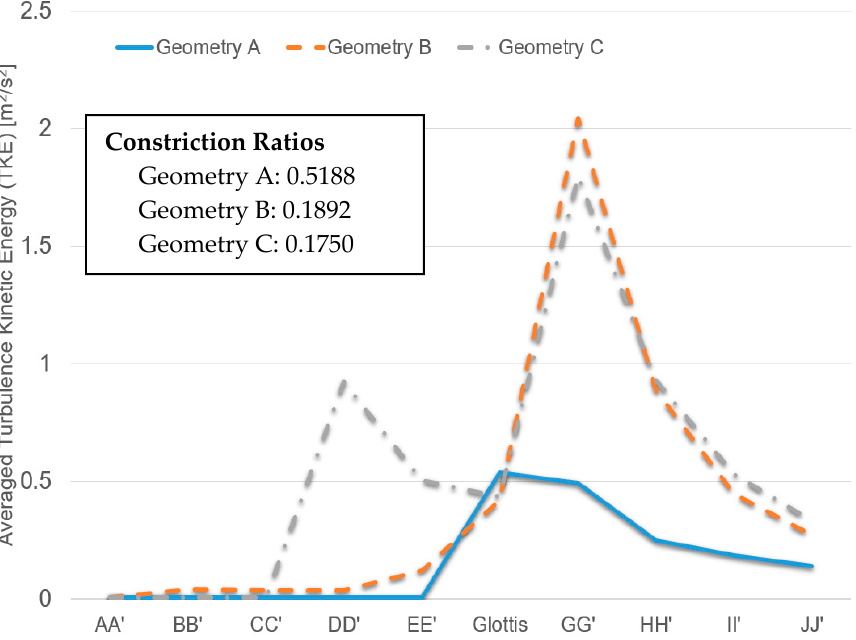
Figure 12. Local turbulence kinetic energies (TKE) under Q in = 37 L/min in the three geometries.